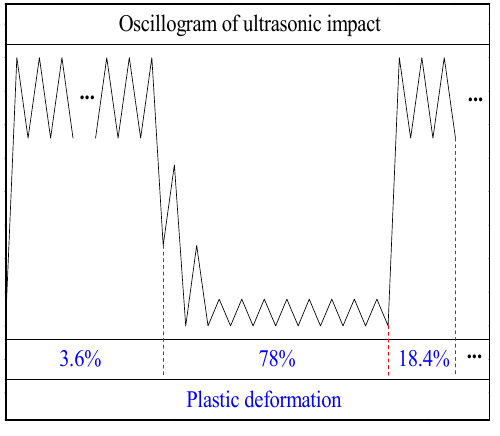
Figure 6. Relation between ultrasonic impact waveform and plastic deformation generation.